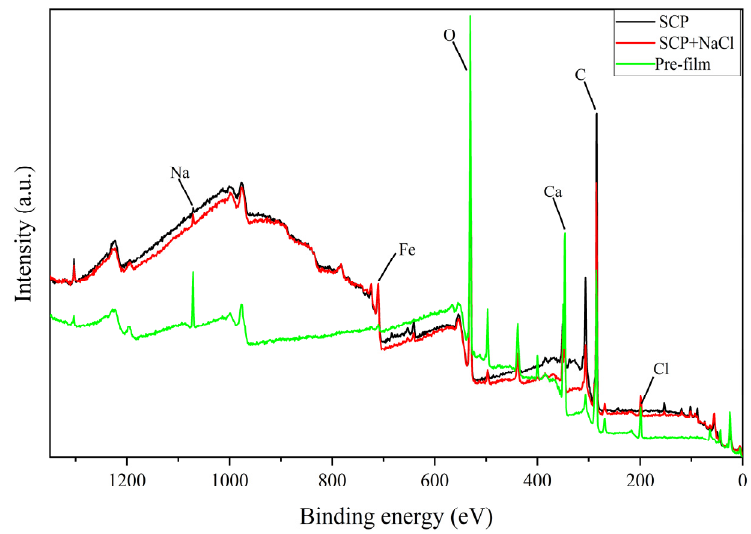
Figure 7. XPS full spectrums of carbon steel electrode surface in different